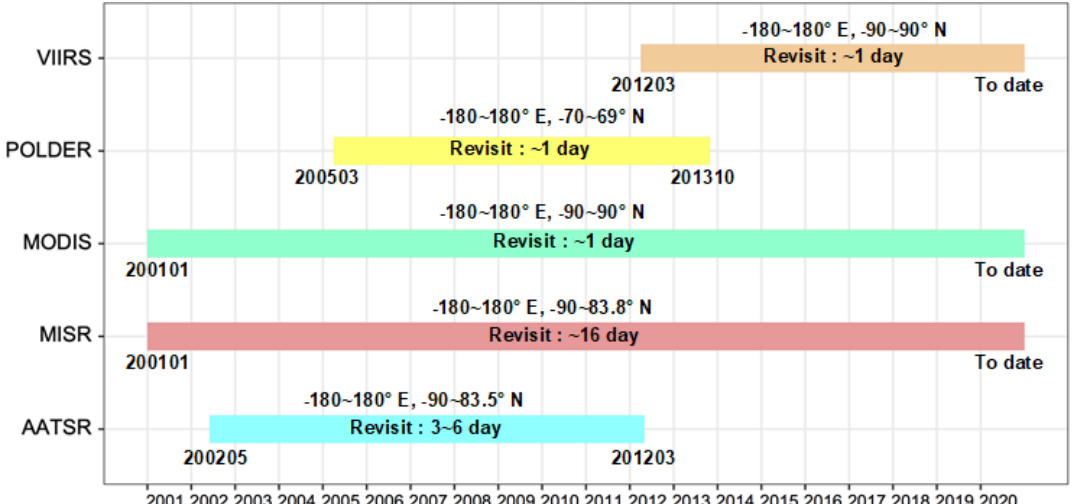
Figure 1. Overview of the time periods covered by different satellites that provide global scale FMF products. AATSR Advanced Along-Track Scanning Radiometer; MISR Multiangle Imaging Spectroradiometer; MODIS Moderate Resolution Imaging Spectroradiometer; POLDER Polarization and Directionality of the Earth’s Reflectances; VIIRS Visible Infrared Imaging Radiometer